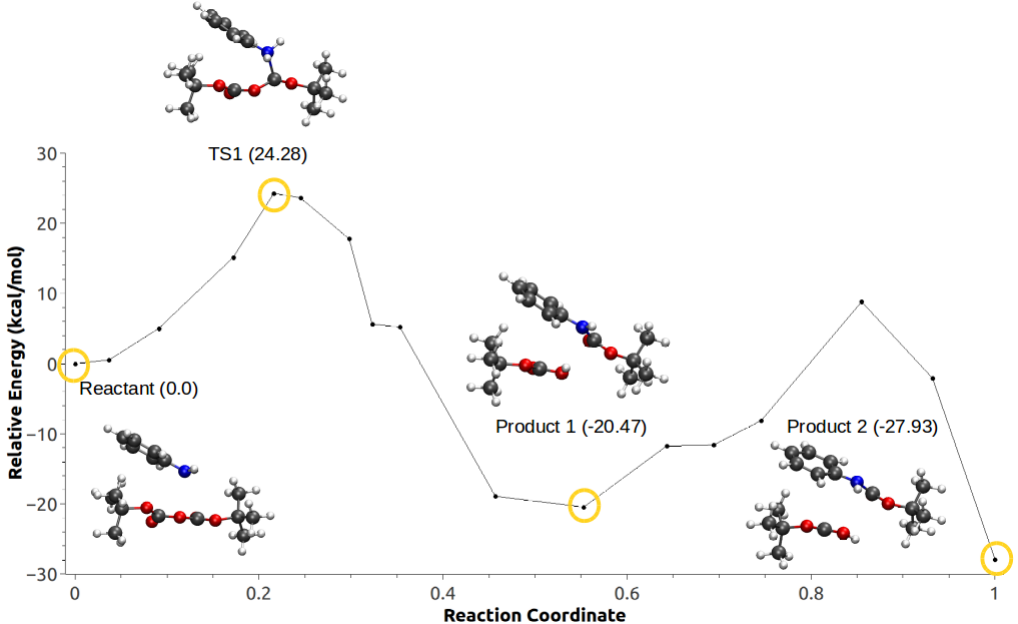
Figure 3. Minimum energy path for Configuration C1, Scheme 1c.